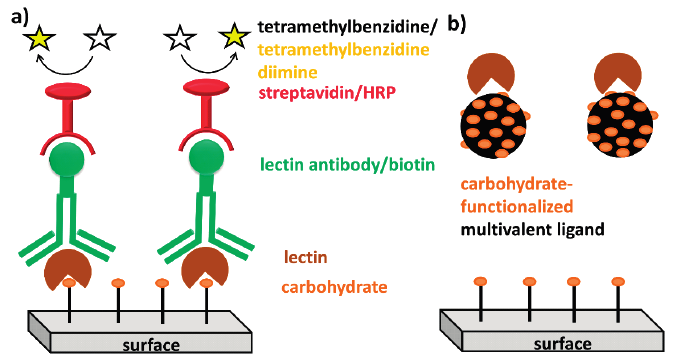
Figure 1. ( a ) Traditional ELISA with saccharide functionalized surface. Lectin binding is indicated by enzymatic oxidation of TMB, which produces a measurable color change; ( b ) Inhibition of lectin binding by a synthetic multivalent glycoconjugate is indicated by the absence of TMB